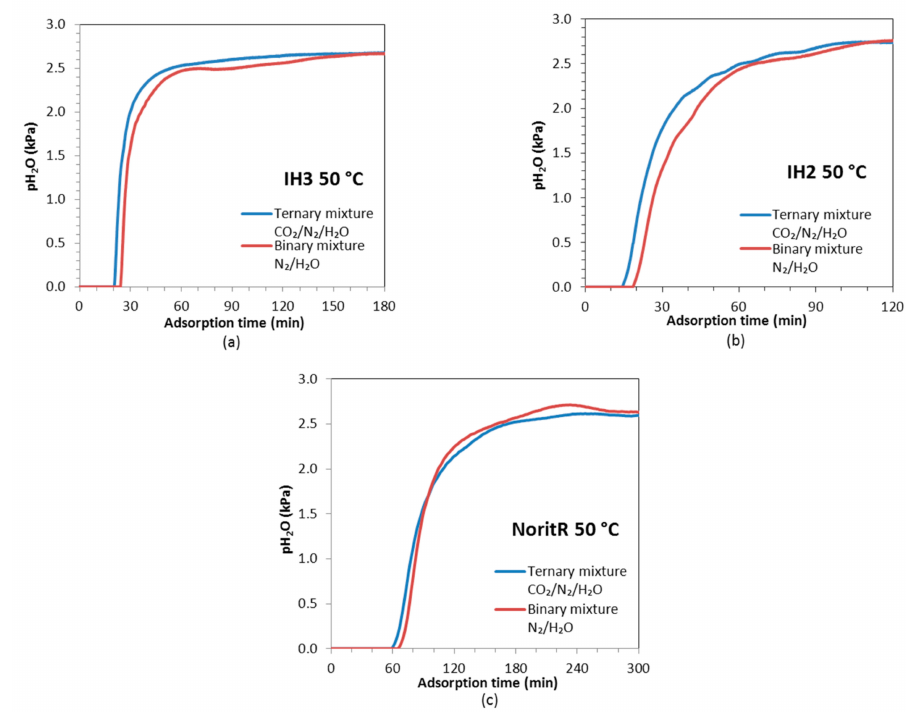
Figure 12. Evolution of the partial pressure of water vapor at 50 ◦ C over time up to saturation for a ternary N 2 /CO 2 /H 2 O mixture (blue) and a binary H 2 O/N 2 one (red) for samples: ( a ) IH3; ( b ) IH2; and ( c ) Norit